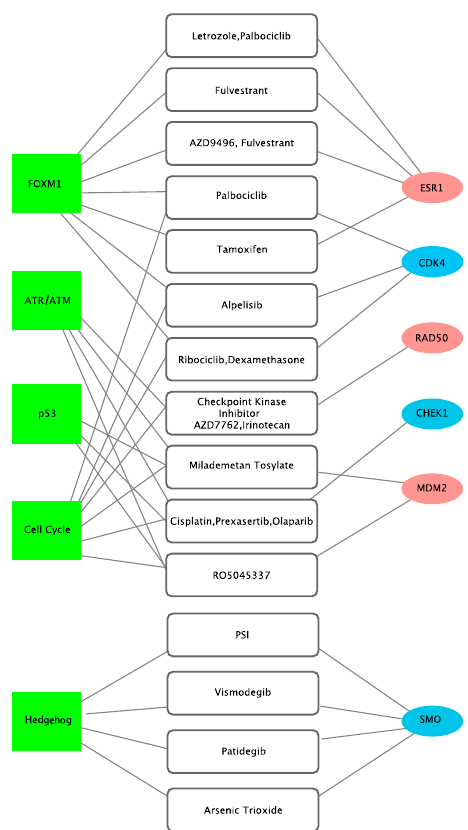
Figure 5. Drug-target network of ESR1-CCDC170 fusion-positive BRCA cancer. Network visualization was demonstrated with Cytoscape, and drug-target relationship was identified with CIViC and OncoKB. Green boxes are representative of pathways, white boxes of drugs, and oval boxes of genes. Red oval boxes are genes that are over-expressed in fusion-positive cancer, whereas blue oval boxes are genes that are under-expressed in fusion-positive cancer.